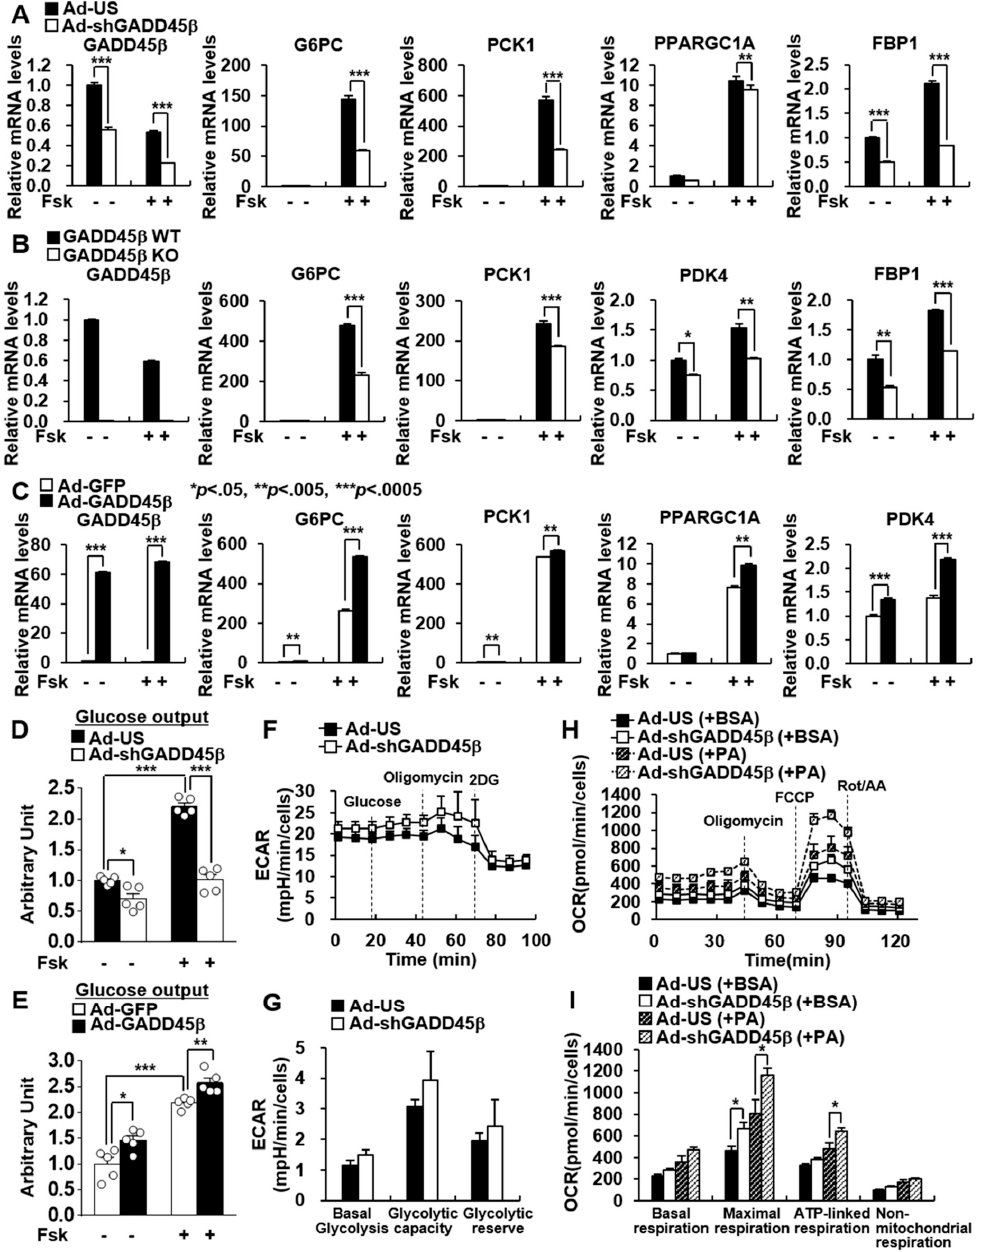
Figure 2. Hepatic GADD45 β regulates glucose production by modulating gluconeogenesis. ( A – C ) qPCR analysis showing the effects of GADD45 β knockdown ( A ), knockout ( B ), and overexpression ( C ) on expression levels of GADD45 β and gluconeogenic genes. Mouse primary hepatocytes were infected with the Ad-US (control) or Ad-shGADD45 β (knockdown) for 72 h ( A ) or with Ad-GFP or Ad-GADD45 β for 48 h ( C ). Cells were treated with or without 10 uM Fsk for 2 h. ( D ) Glucose production in mouse primary hepatocytes infected with Ad-US or Ad-shGADD45 β . ( E ) Glucose production in mouse primary hepatocytes infected with Ad-GFP or Ad-GADD45 β . ( F – I ) Mouse primary hepatocytes were infected with Ad-US or Ad-shGADD45 β . ( F , G ) Measurement of Glycolytic rate using extracellular acidification rate (ECAR). Cells were incubated with glucose, oligomycin, and 2DG. ( H , I ) Measurement of FA oxidation (FAO) using oxygen consumption rate (OCR). Cells were incubated with BSA or palmitate (PA), oligomycin, FCCP, rotenone, and antimycin A. Data in ( A – C , I ) represent the mean ± SD, and data in ( D , E ) represent the mean ± SEM (* p < 0.05; ** p < 0.005; *** p < 0.0005; t